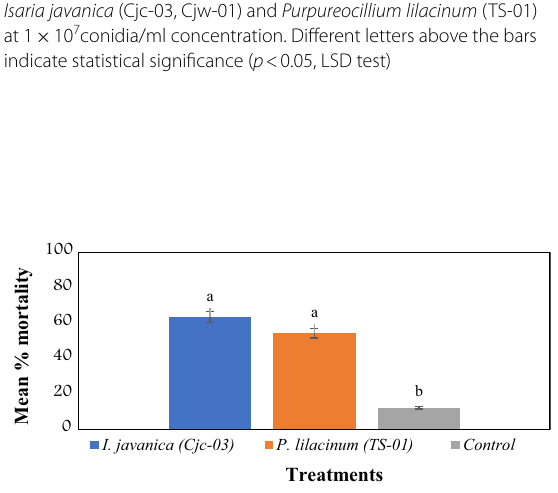
Fig. 8 Mortality (%) of Bemisia tabaci at 3 DAT when treated with 2 isolates (Cjc-03 and TS-01) at 1 10 7 conidia/ml concentration. × Different letters above the bars indicate statistical significance ( p <